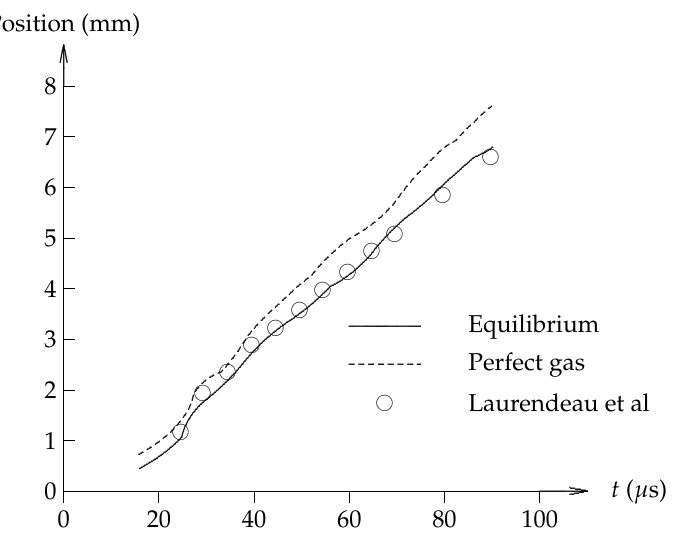
Figure 22. Jet position versus time. Figure 20. Jet position versus Table 5. Effect of Electrode Location